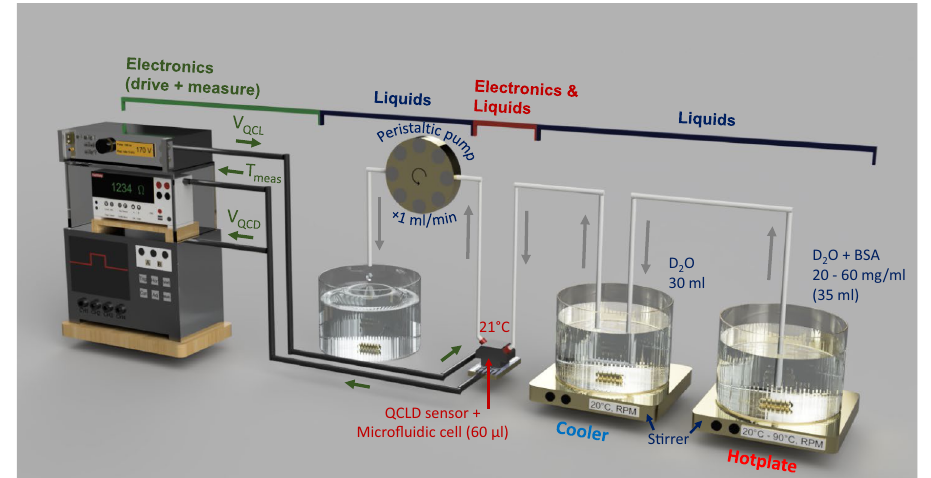
Fig. 5 | Denaturation measurement setup. We use a custom-made 60- μ l cell for thisexperiment. The stock solution (35ml BSA in D 2 O at20, 40,and 60mgml − 1 ) is constantly heated from room temperature to 90 ∘ C, while being continuously